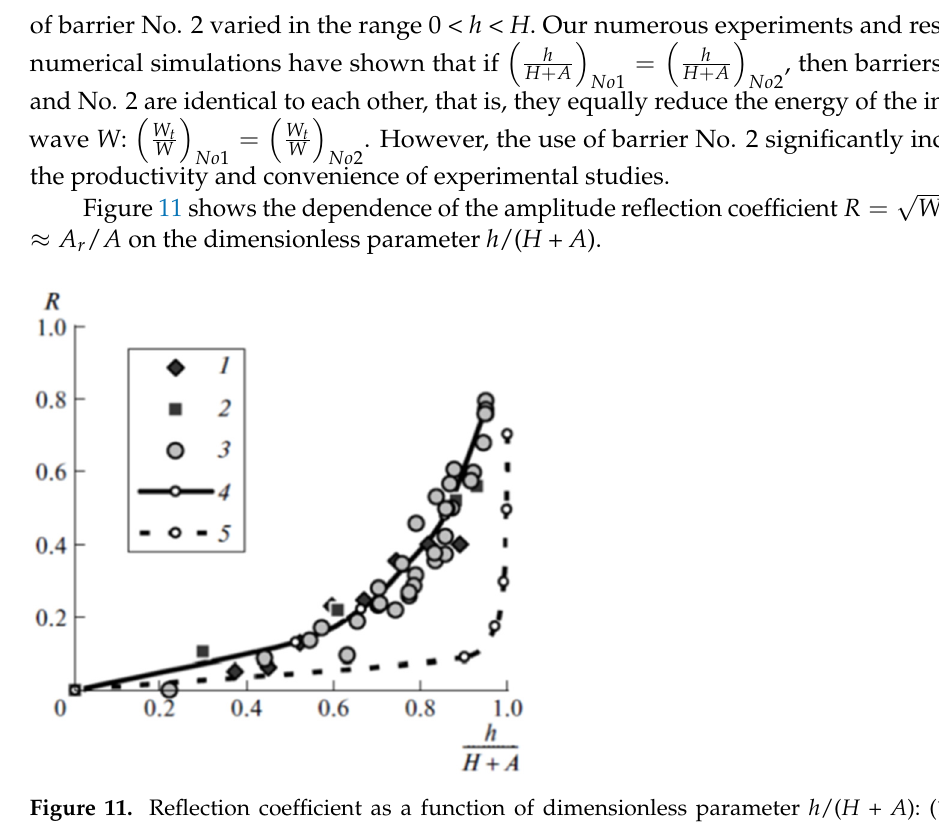
Figure 11. Reflection coefficient as a function of dimensionless parameter h /( H + A ): (1)—No. 1, A/H = 0.286 [4]; (2)—No. 1, A/H = 0.04–0.05; (3)—No. 2, A/H = 0.04–0.10; (4)—Navier–Stokes Equations, A/H = 0.07 and (5)—linear theory of long waves.